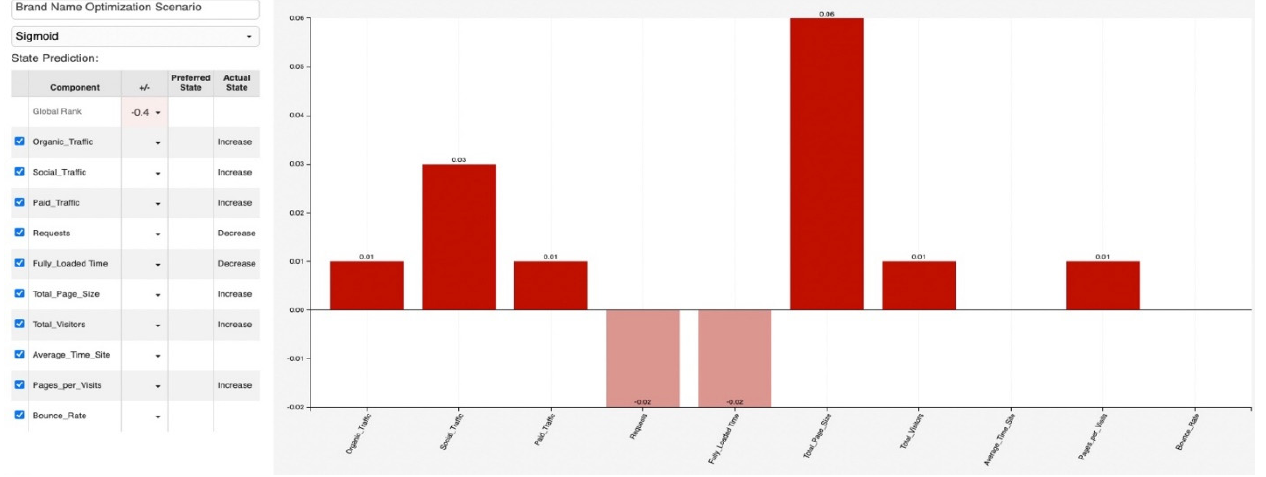
Figure 4. Brand Name Optimization Scenario.